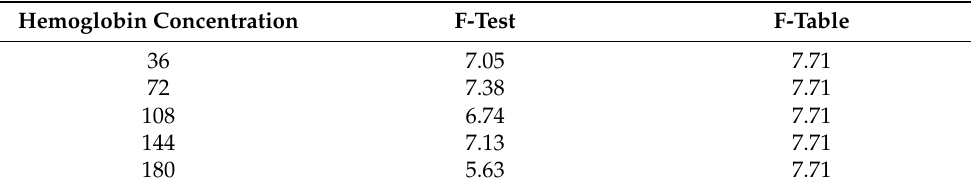
Table 3. F-test result from MATLAB for N = 3.